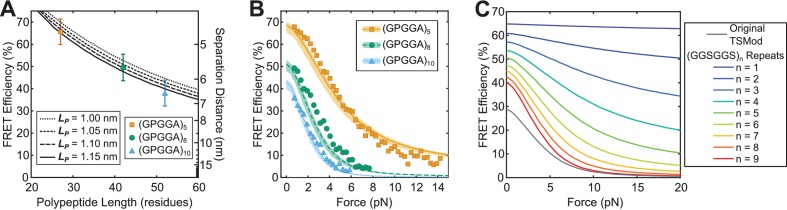
Predicting TSMod calibrations using a biophysical model.(A, B) Model descriptions, at various persistence lengths (LP), of FRET-polypeptide length relationship (A) and FRET-force responses (B) of Cy3 and Cy5 dyes linked by SMCC linker + cysteine modified (GPGGA)n polypeptides; data was digitized based on histograms from (Brenner et al., 2016); model parameters R0=5.4nm, RFP=0.95nm, LP=1.05nm (range 1.00 to 1.15nm); error bars, s.d. (C) Model predictions of force sensitivity of TSMods comprised of Clover-mRuby2 FRET pair and (GGSGGS)n extensible domains in comparison to the original TSMod (Grashoff et al., 2010); model parameters R0=6.3nm, RFP=2.3nm, LP=0.48nm.10.7554/eLife.33927.020Figure 2—source data 1.Measurements and models of the mechanical behavior of TSMod-like constructs in vitro.